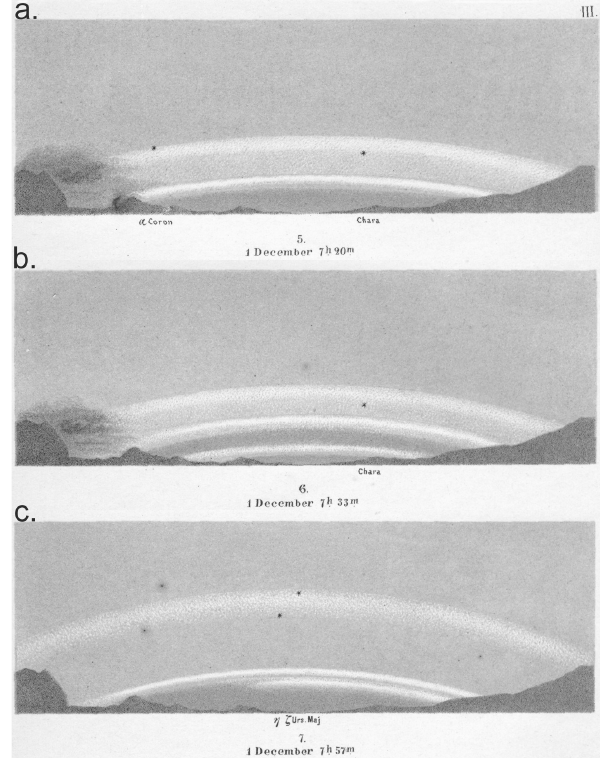
Figure 3. Tromholt’s sketches of the auroral displays on 1 Decem- ber 1878 (from Tromholt, 1880a).